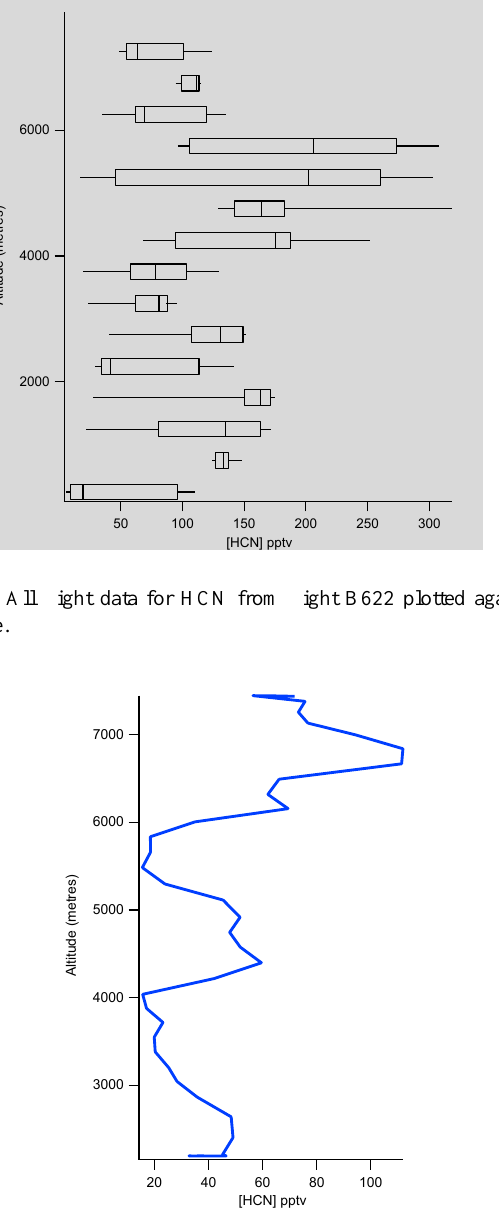
Fig. 7. Altitudinal profile performed during flight B622 in “clean air”.